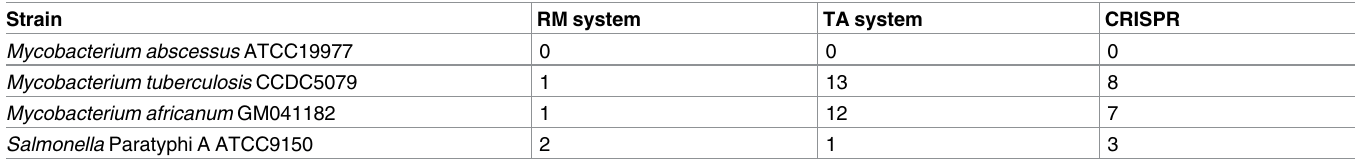
Table 2. Bacterial defense systemfor Mycobacterium abscessus compared to other bacterial genomes. Strain RM system TA system